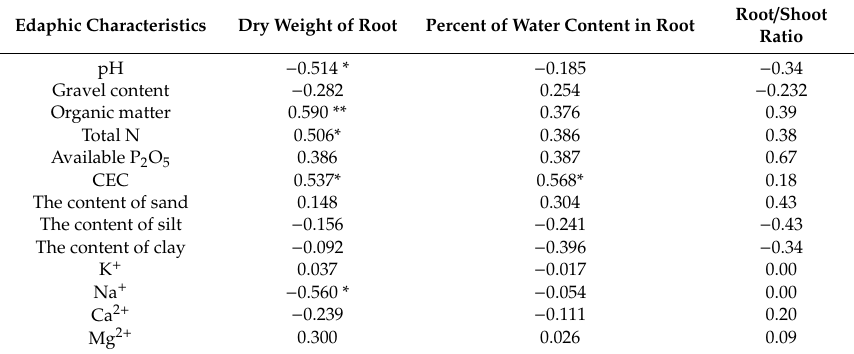
Table 5. Correlation coe ffi cients between root growth characteristics and edaphic characteristics in Angelica gigas Nakai cultivation sites,